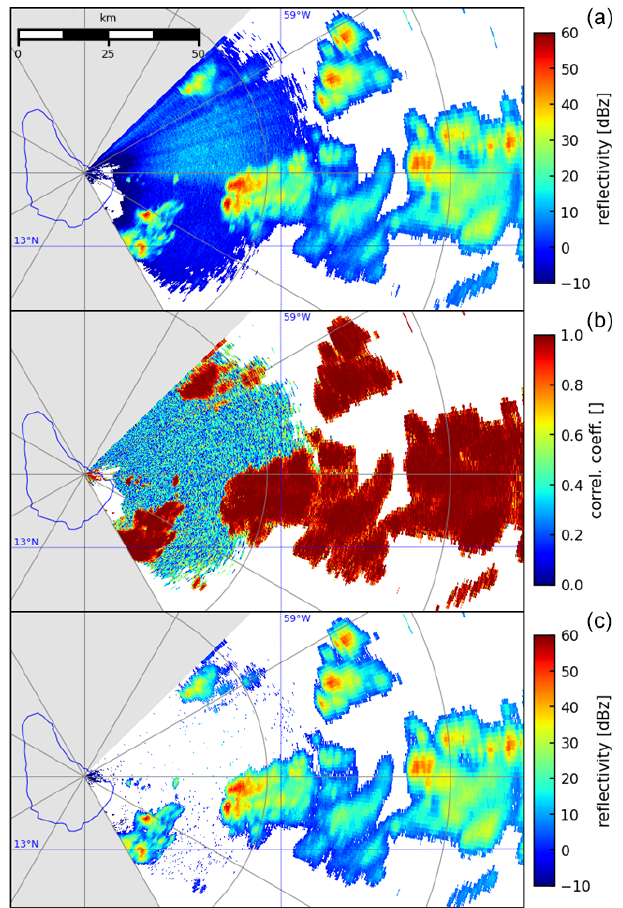
Figure 6. PPI scan with elevation 0.5 ◦ on 11 February 2020 at 12:07:25UTC. (a) Reflectivity horizontal polarization Z H . (b) Copolar correlation coefficient ρ HV . (c) Reflectivity Z H , where ρ HV > 0.7.